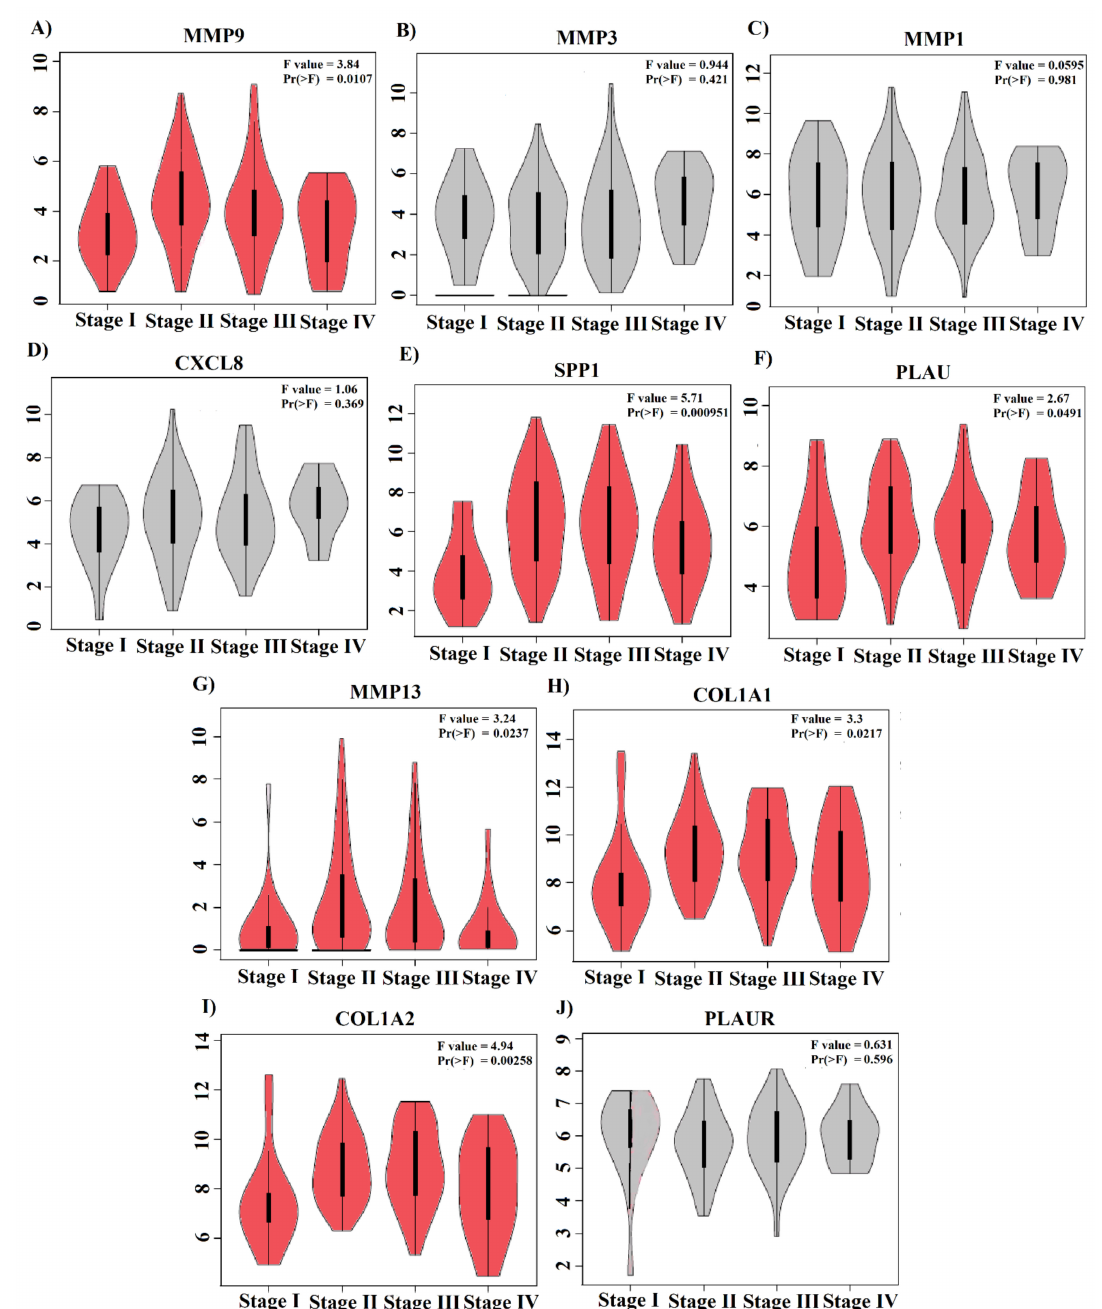
Figure 5. The association between HGsT10 expression and ESCA stages was analyzed by stage-plot with the F and Pr (>F) value. ( A – J ) Gene expression patterns of the HGsT10 validated with TCGA database. Log2(TPM + 1) was used for the log scale. (Red violin plotted genes are associated with ESCC major stages namely ( A ) MMP9, ( E ) SPP1, ( F ) PLAU, ( G ) MMP13, ( H ) COL1A1, ( I ) COL1A2, and grey violin plotted genes are not associated with major stages namely ( B ) MMP3, ( C ) MMP1, ( D ) CXCL8, and ( J )